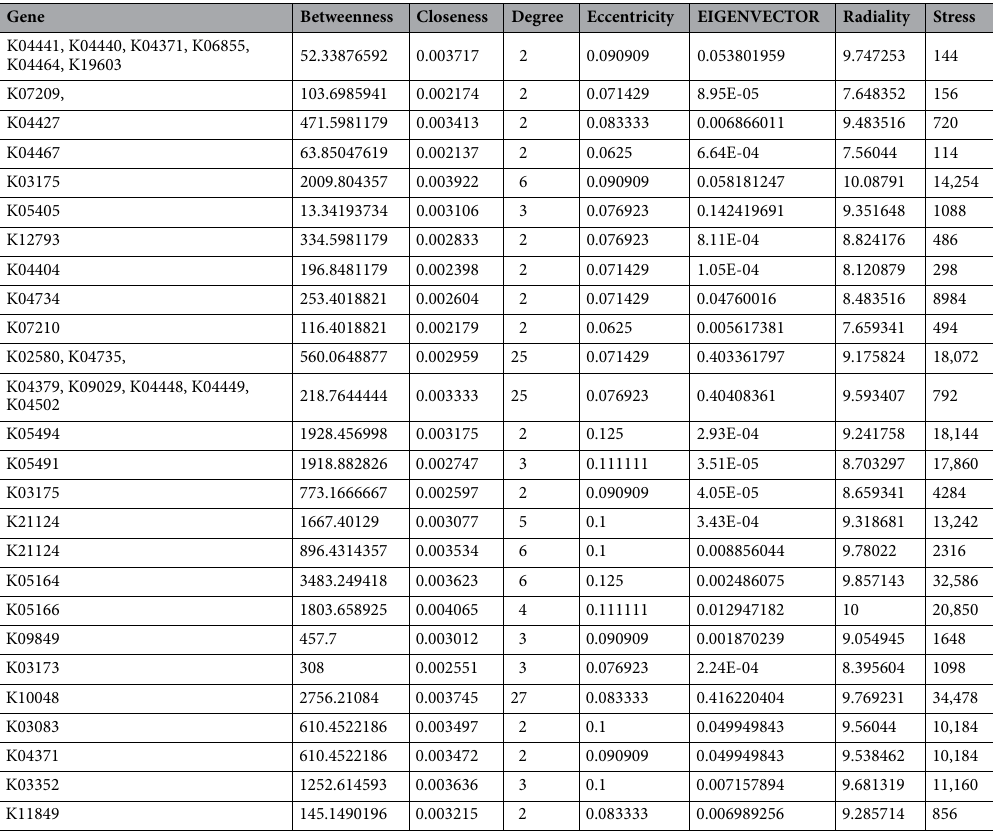
Table 2. The results of threshold parameter values of the MAPK6 network